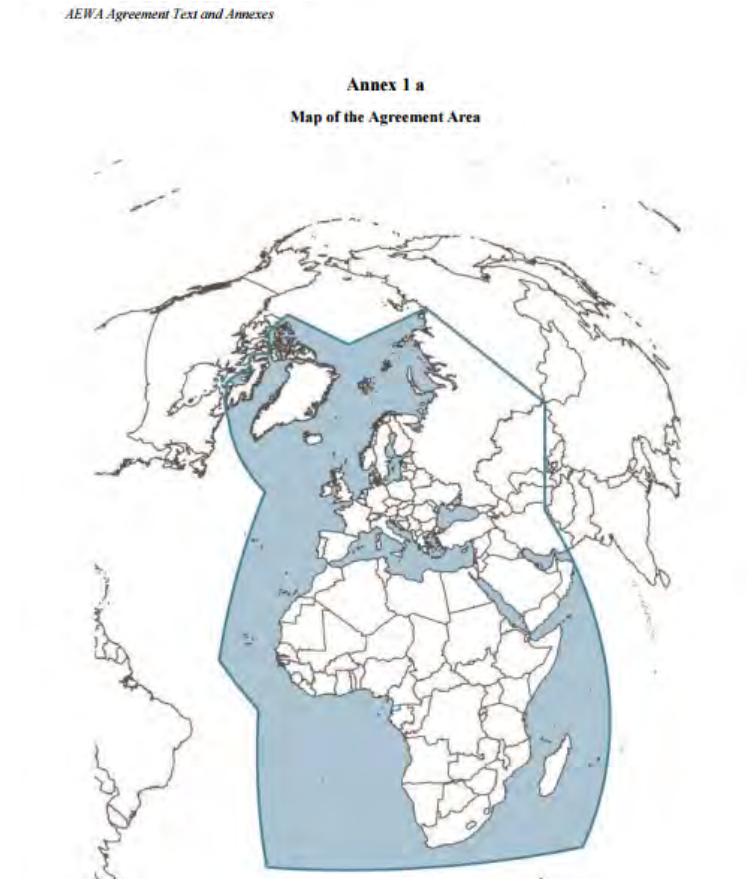
Figure 4. Geographical scope of AEWA (Contracting Parties as ofAugust 2008). Source; AEWA Strategic Plan 2009 - 2017. p4.